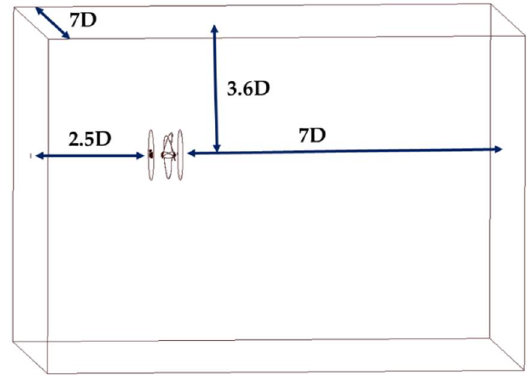
Figure 13. 3D computational domain.